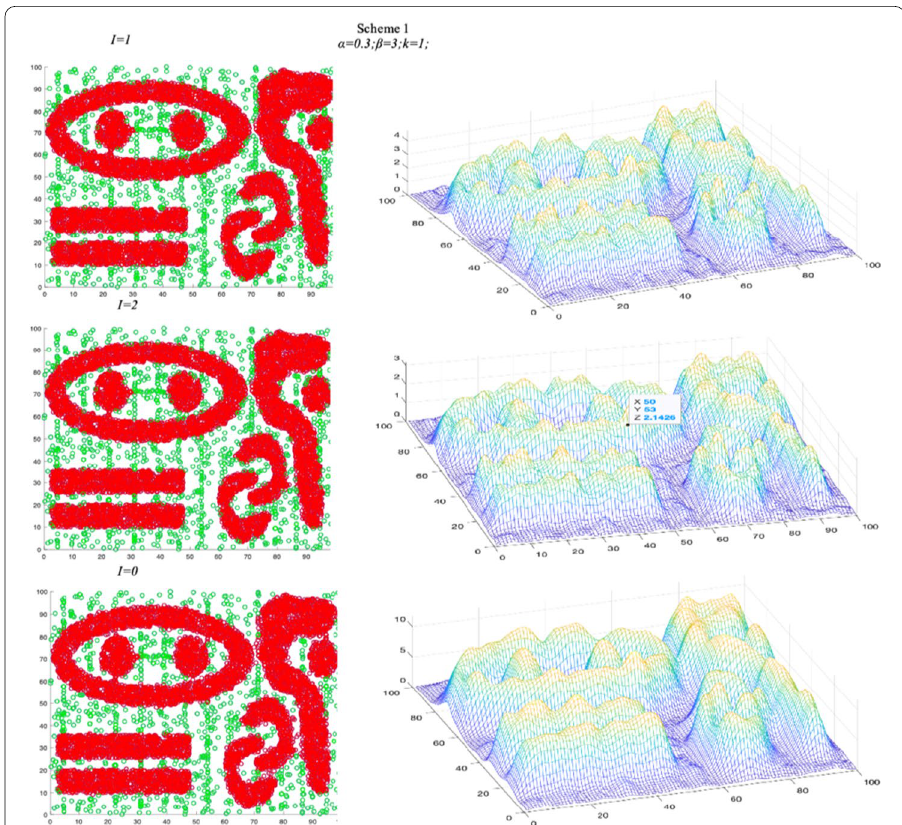
Fig. 9 Second example of Outlier Detection results using scheme 1 with α shown in green and the inlier data in